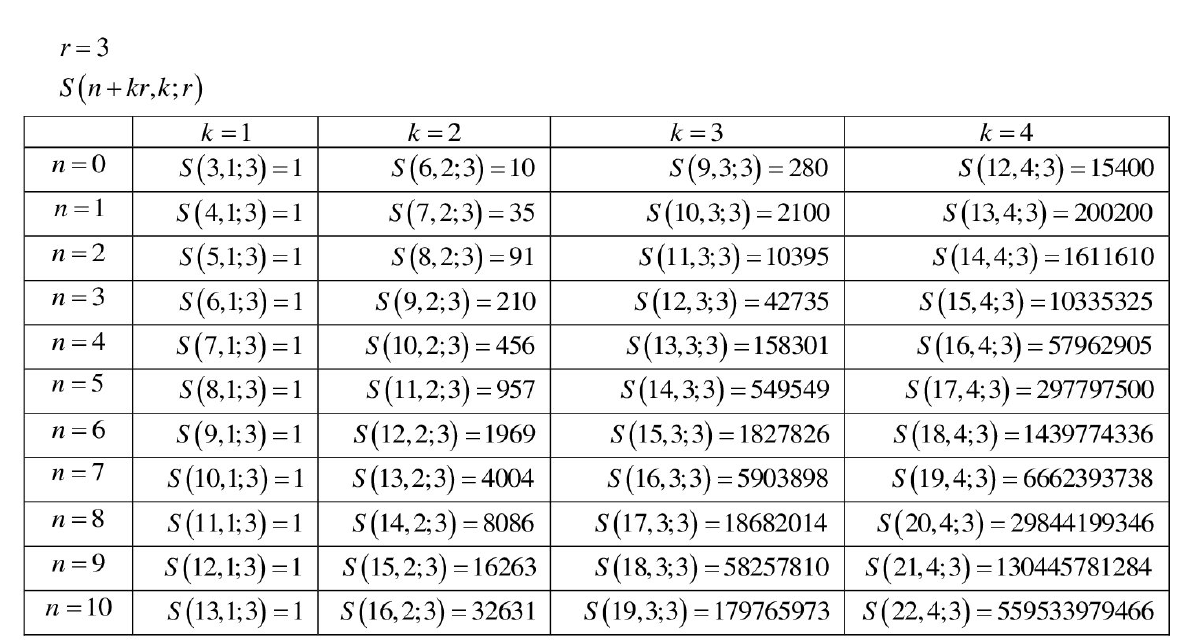
Figure 5. Numbers S ( n + 2 k , k ;2 ) , k = 1,2,3,4; n = 1,2, . . . ,10.